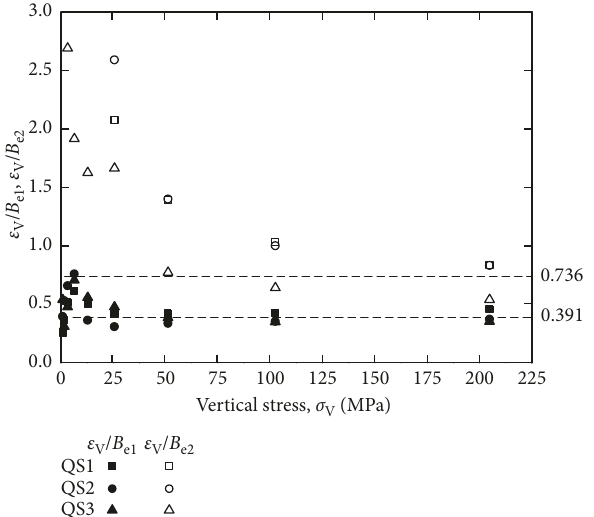
Figure 12: Relationship between σ